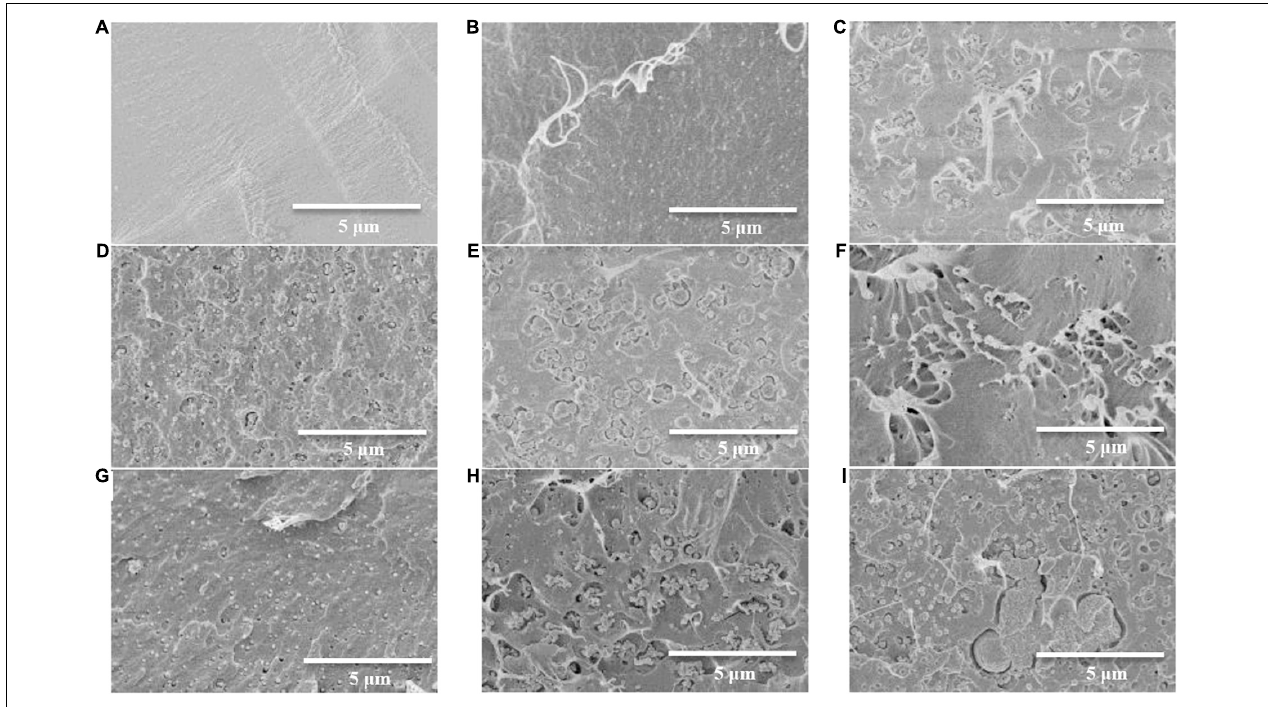
FIGURE 8 | SEM images of the fracture surface of PLA and PLA-based composite films. (A) Pure PLA film; (B) 1%Ac–RWC/PLA composite film; (C) 3%Ac–RWC/PLA composite film; (D) 5%Ac–RWC/PLA composite film; (E) 7%Ac–RWC/PLA composite film; (F) 1%Ac–RW–CNC/PLA composite film; (G) 3%Ac–RW–CNC/PLA composite film; (H) 5%Ac–RW–CNC/PLA composite film; (I) 7%Ac–RW–CNC/PLA composite